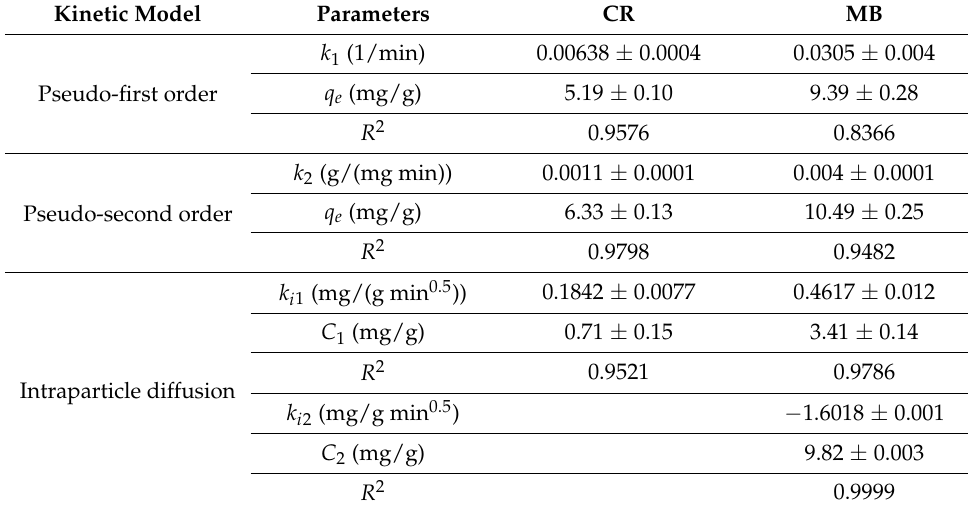
Table 2. Kinetic parameters for nonlinear modeling adsorption kinetics (Equations (3)–(5)), for